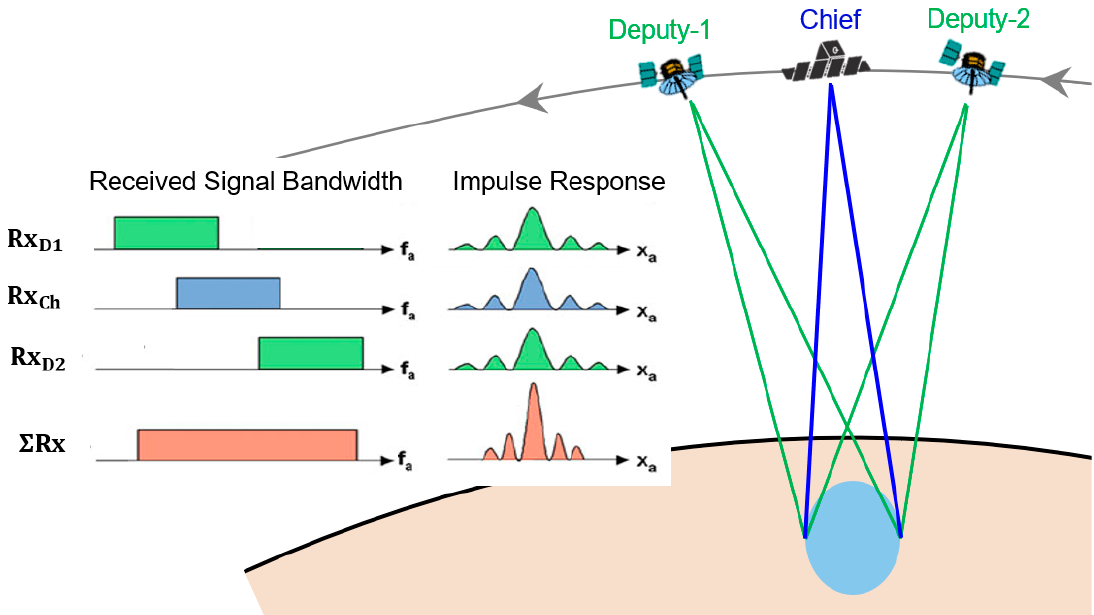
Figure 2. Multistatic SAR concept for VHRSI. Three satellites receive signals of different bandwidths due to the Doppler frequency gap. The synthesis of all received signals sharpens the impulse response, implying an improvement in azimuth resolution. Table 2. Specification of the multistatic SAR microsatellite